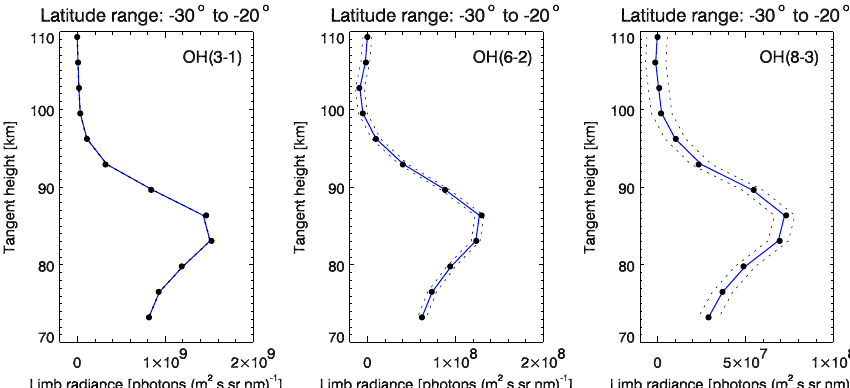
Fig. 3. Comparison of observed and forward modelled limb-radiance profiles – based on the retrieved volume emission rate profiles – for a sample latitude bin and the OH(3-1), OH(6-2) and the OH(8-3) bands. The observed limb-radiance profiles are shown as solid blue lines, the dotted lines indicate the measurement error. The solid black circles correspond to the forward modelled limb-radiance profiles.